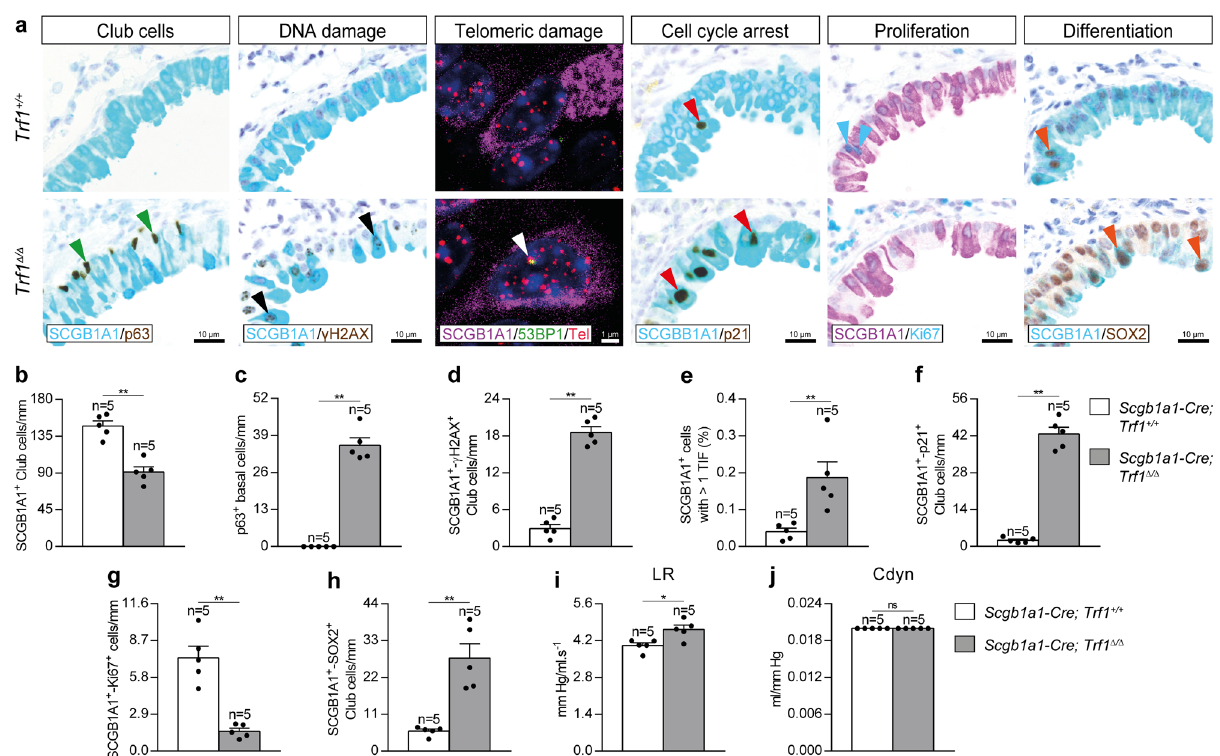
Fig. 6 | Trf1 deletion in club cells increases telomeric damage, cell cycle arrest and differentiation, and reduces proliferation of club cells. a Representative immunostainings for SCGB1A1 (blue) and p63 (brown; green arrowheads indicate p63 + basal cells), SCGB1A1 (blue) and γ H2AX (brown; black arrowheads indicate double SCGB1A1 + - γ H2AX + club cells), SCGB1A1 (blue) and p21 (brown; red arrow- heads indicate double SCGB1A1 + -p21 + club cells), SCGB1A1 (purple) and Ki67 (blue; blue arrowheads indicate double SCGB1A1 + -Ki67 + club cells), and SCGB1A1 (blue) and SOX2(brown;orange arrowheads indicate doubleSCGB1A1 + -SOX2 + clubcells), as well as representative images of telomeric induced foci (TIF) in SCGB1A1 + cells (SCGB1A1 (purple), Cy3Tel probe (red), 53BP1 + cells (green; white arrowheads